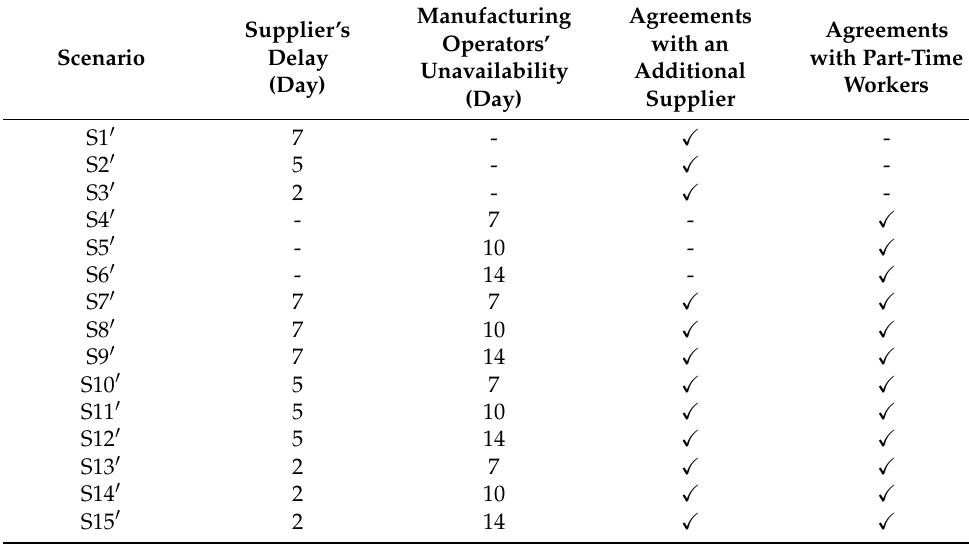
Table 4. Scenarios for assessing possible response strategies to disruptions.